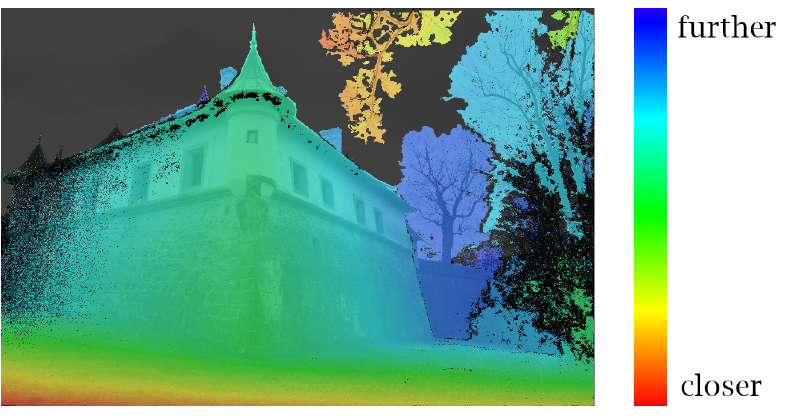
Figure 8. Example of a depth